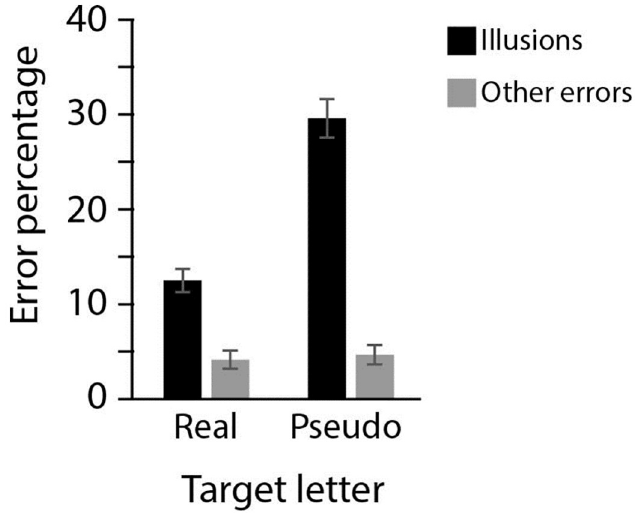
Fig 5. Experiment 3. Error rates in trials where participants indicated high confidence in their response. Percentages of expectation-induced errors and other errors are depicted for pseudo-letter and real letter targets.